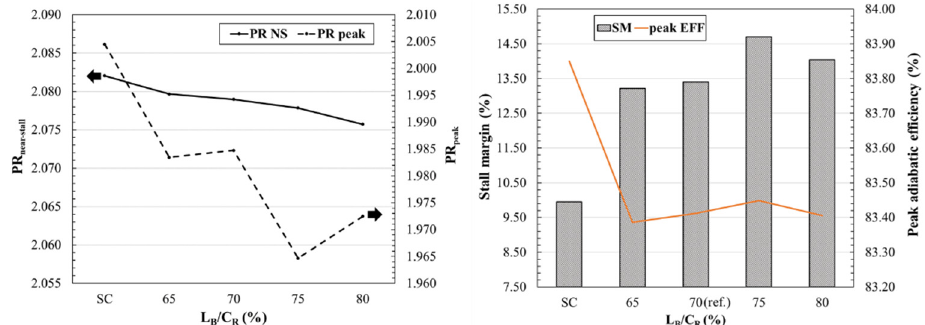
Figure 14. Effects of rear bleed location on performance.